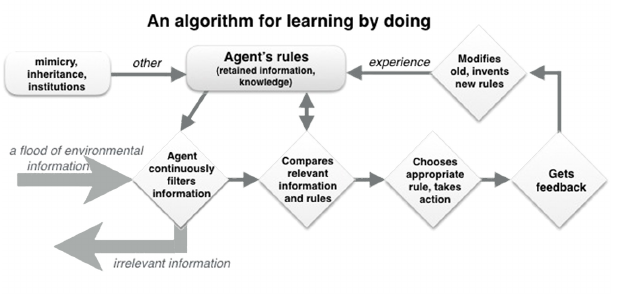
Fig. 1. Learning and adaptation can be modeled using rule- based computational methods, not equations or a conventional agent-based model. The basic structure of an evolutionary model is similar to an agent-based model, but agents learn from experience and change their behavioral rules in response. variation, as in any evolutionary process. The